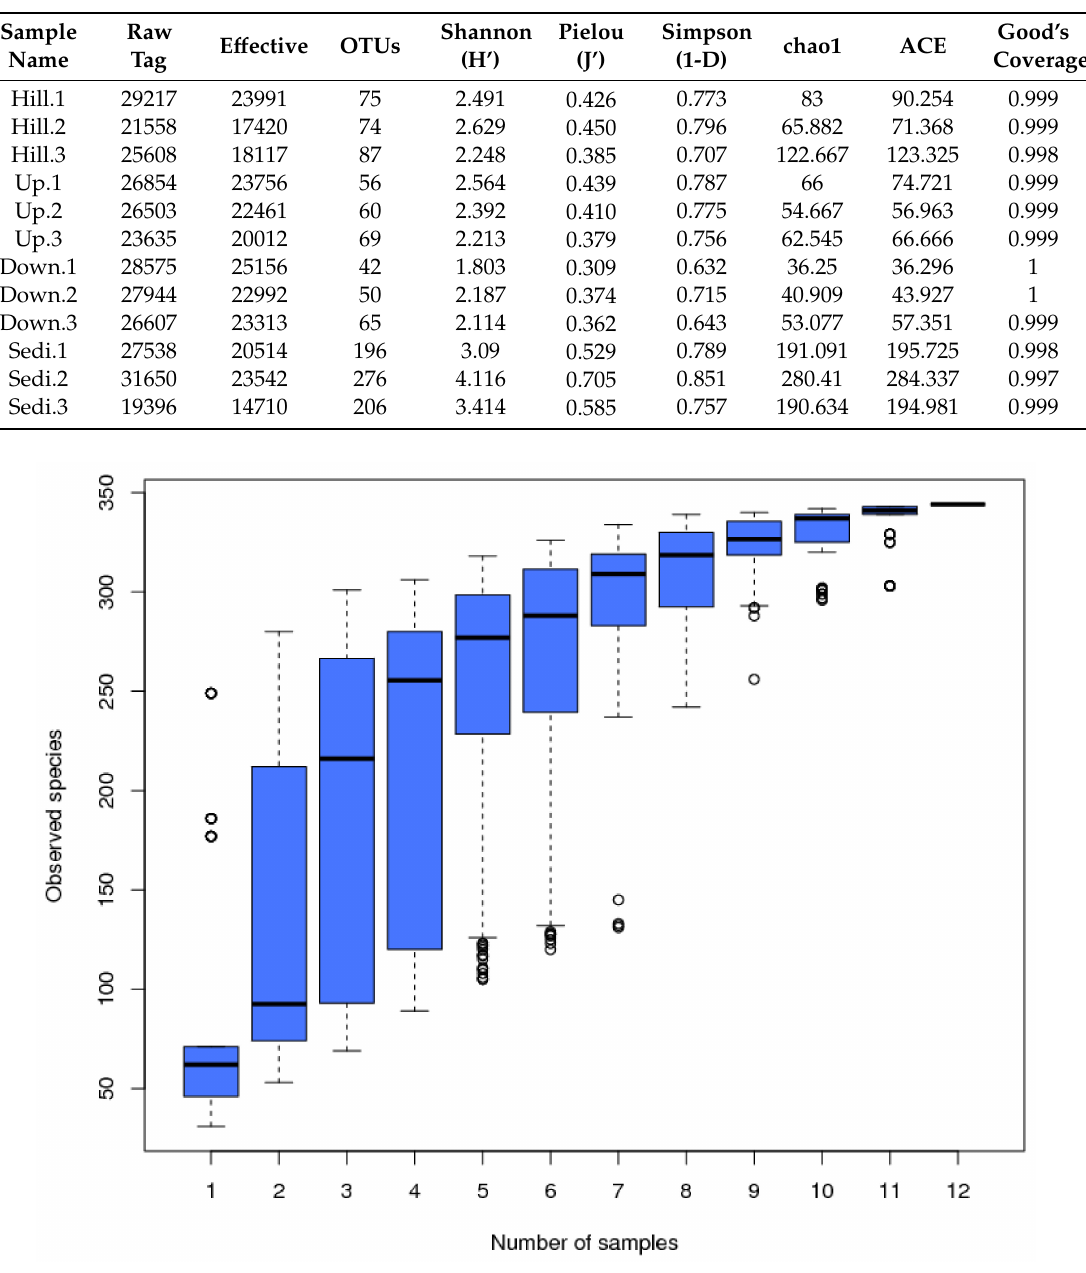
Table 2. Summary data for the Miseq sequencing data from the 12 samples in the present study.